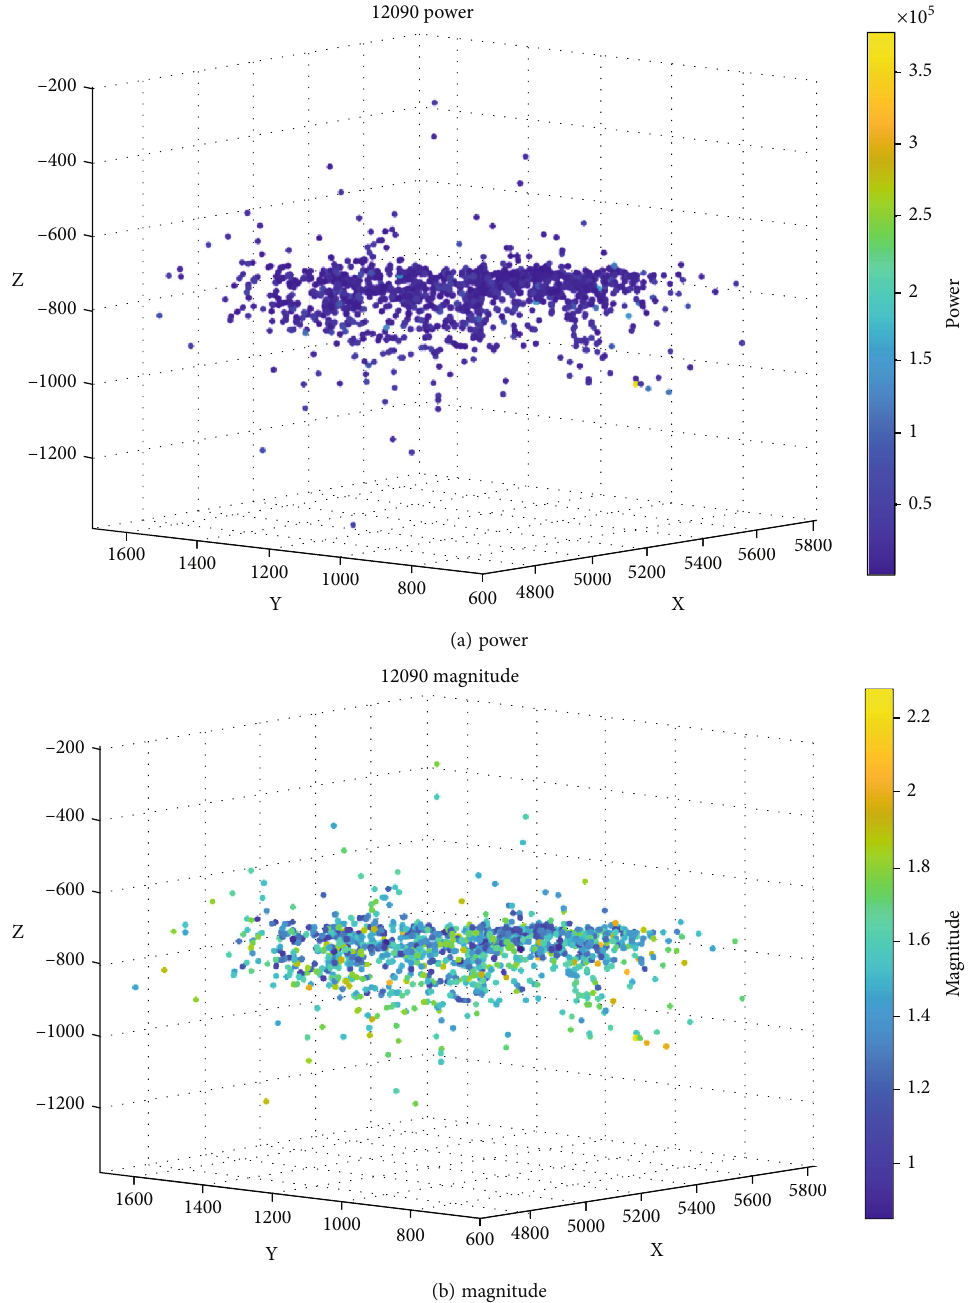
Figure 3: Energy and magnitude of 12090 working face coal